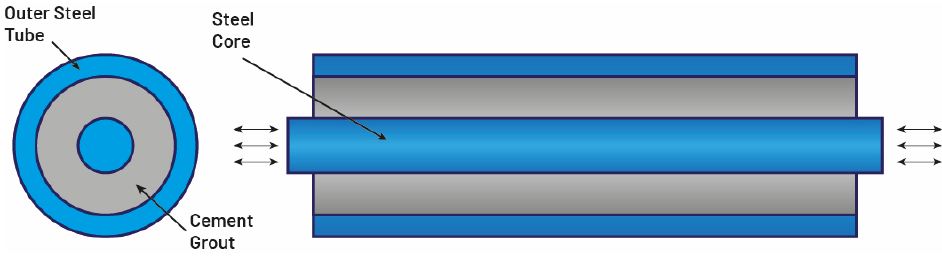
Figure 2. Section view of buckling restrained braces (BRBs) (Adapted with permission from [5]).